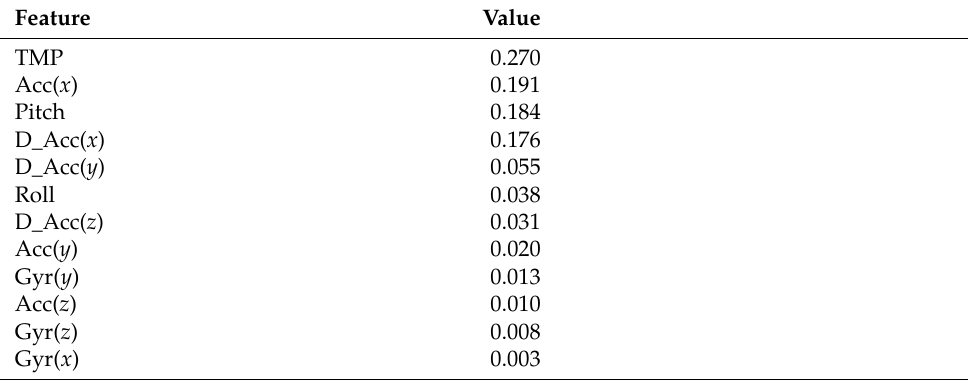
Table 4. Feature importance of the best